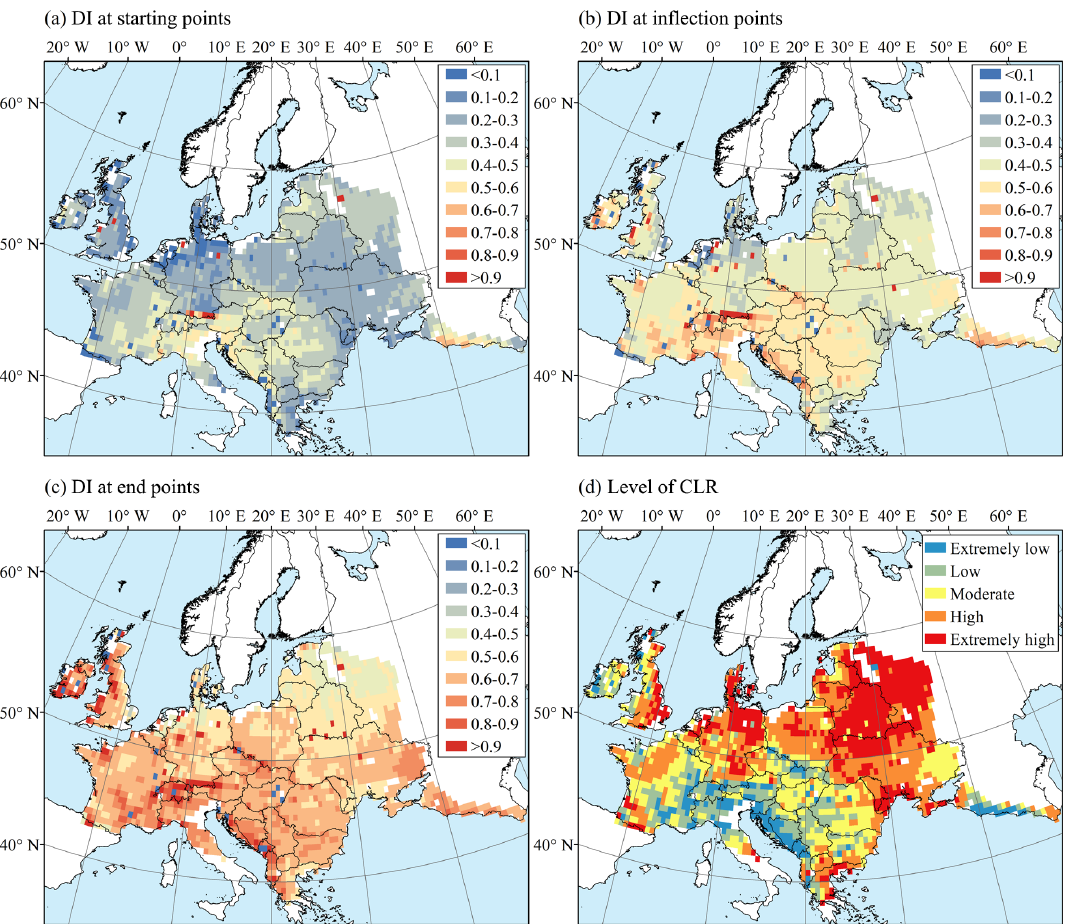
Figure 6. Spatial distributions of drought index (DI) at the (a) starting points, (b) inflection points, and (c) end points and (d) spatial distribution of the level of the cumulative loss rate (CLR) of vulnerability curves. Table 3. Clustering effect of different cluster